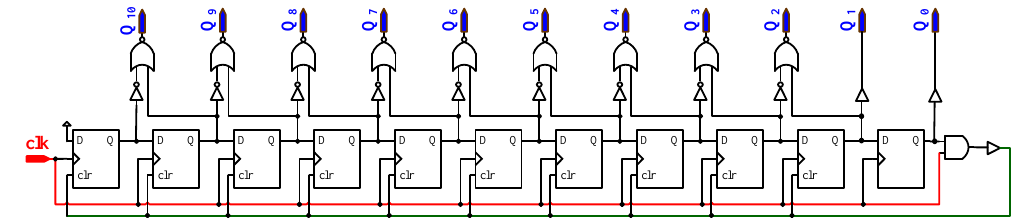
Electronics 2021 , 10 , x FOR PEER REVIEW Figure 7. Logic circuit diagram of the conversion step, which is used to generate 11 step signals, Q 0 –Q 10 .